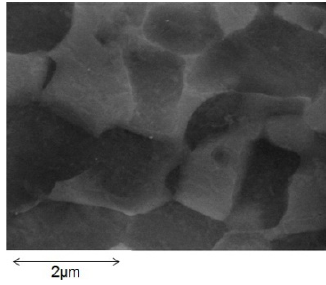
Figure 14. Scanning electron micrograph of